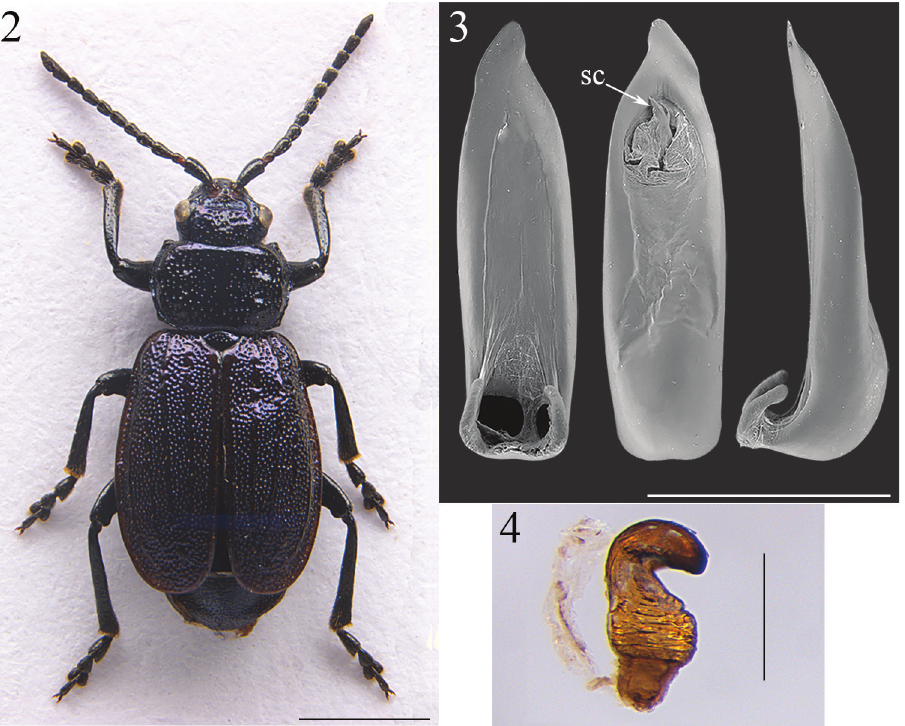
Figures 2–4. Belarima violacea (Lucas) 2 habitus (Tuscan coast, Rosignano Solvay, male) 3 median lobe of aedeagus, from left to right in ventral, dorsal and lateral view (Tuscan coast, Rosignano Solvay) 4 spermatheca (Tuscan coast, Rosignano Solvay). sc: sclerite of the internal sac. Scale bars: 2 mm ( 2 ); 1 mm ( 3 ); 0.2 mm ( 4